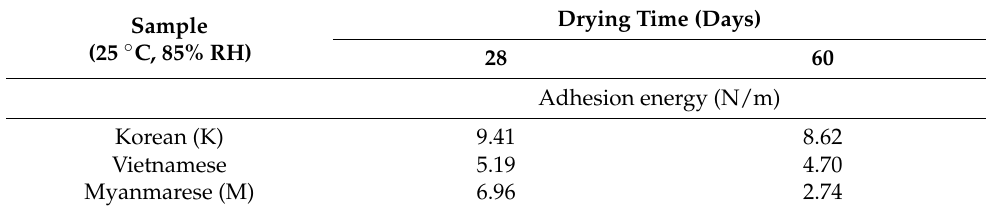
Table 5. Adhesion strengths of Oriental lacquer films on a glass slide by 90 ◦ peel